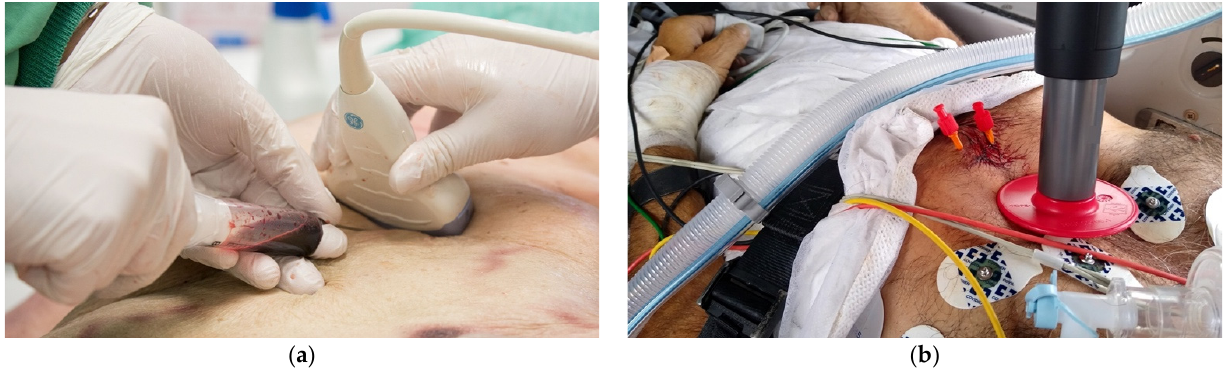
Figure 4. ( a ) Ultrasound-guided pericardiocentesis in a cadaveric model: The convex-array trans- ducer is placed subxiphoidal to obtain a subcostal window 4-chamber view (S4CH) in order to guide the needle precisely under sight and thus achieve higher success rates; ( b ) Helicopter transport of a patient in sustained return of spontaneous circulation (ROSC) after ultrasound-guided relief of per- icardial effusion in the field by the catheter-over-needle technique. Catheters have been left in place. An automated mechanical cardiopulmonary resuscitation (mCPR) device has been applied precau- tionarily. applied